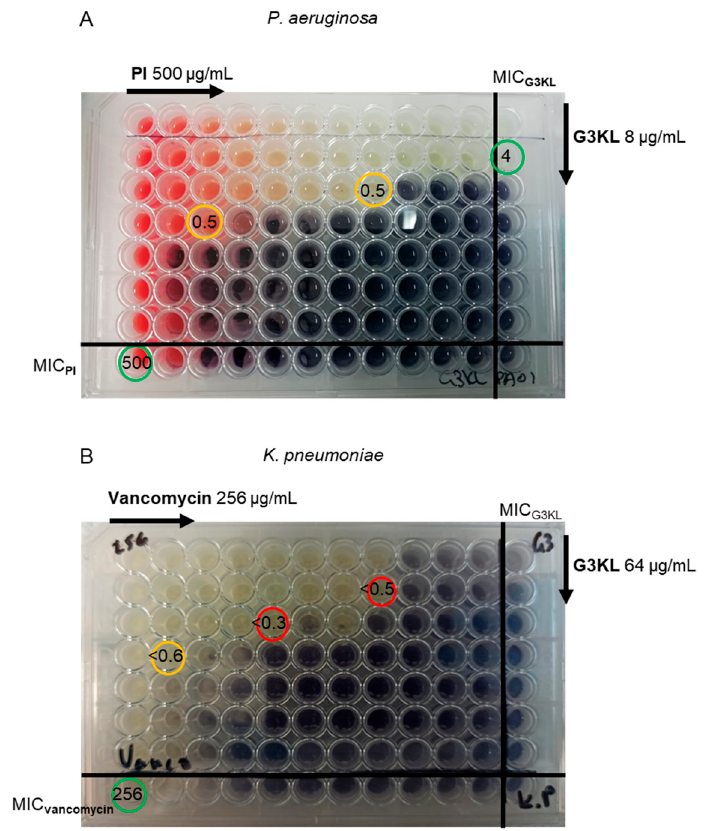
Figure 2. Checkerboard microtiter plate assay testing the combination of G3KL with PI in P. aeruginosa PAO1 ( A ) and vancomycin with G3KL in K. pneumoniae NCTC 418. ( B ) 2D two-fold serial dilutions were performed starting with 500 μ g/mL of PI , 256 μ g/mL of vancomycin, and 8 or 64 μ g/mL of G3KL . The viability of the bacteria was revealed after the addition of 3-(4,5-dimethylthiazol-2-yl)-2,5-diphenyltetrazolium (MTT) dye (black wells). Red circle: FIC i of synergistic effect; yellow circles: FIC i of partial synergy; green circles: MIC values of G3KL , PI , and vancomycin. Table 1. Activity of G3KL and PMB in combination with PI .